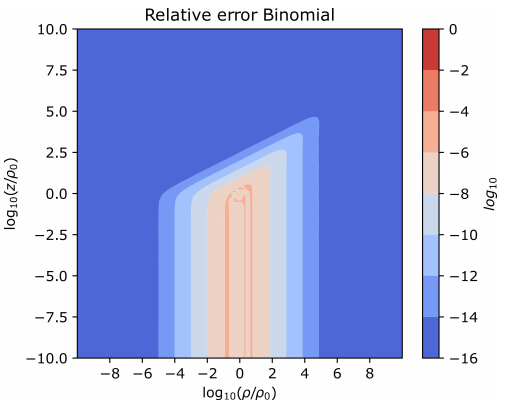
Figure 7. Vectorwise relative error of the binomial expansion for the B -field of a current